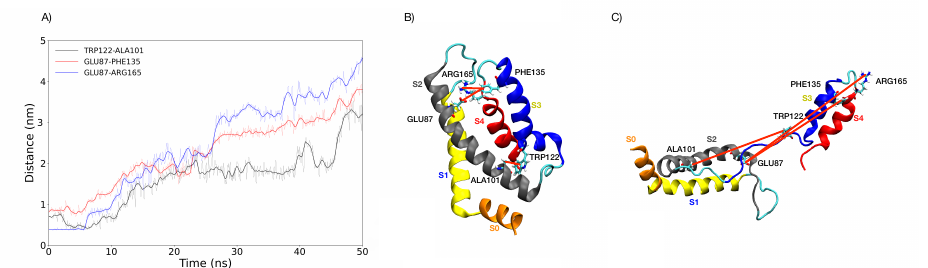
Figure 6. ( A ) Distances as a function of time between different VSD amino acid residues of a representative replica of Box 2 under an (cid:126) E = 0.2 V/nm during 50 ns. In black, the distance between TRP 122 and ALA 101; in red, the distance between GLU 87 and PHE 135; in blue, the distance between GLU 87 and ARG 165. ( B ) Representation of the amino acid residues plotted and their distance at the beginning of the simulation with (cid:126) E = 0.2 V/nm. ( C ) Representation of the amino acid residues plotted and their distance at the end of the 50 ns of a representative simulation under (cid:126) E = 0.2 V/nm. The S0–S4 helices are highlighted in orange, blue, gray, yellow and red,